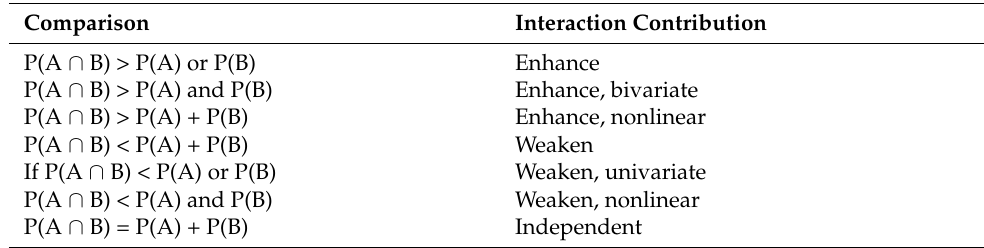
Table 1. Interaction between A and B.